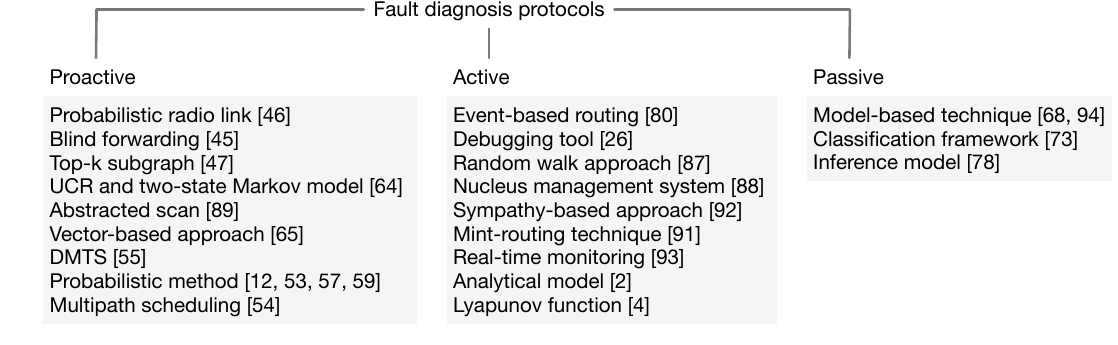
Figure 2. Fault diagnosis protocols.